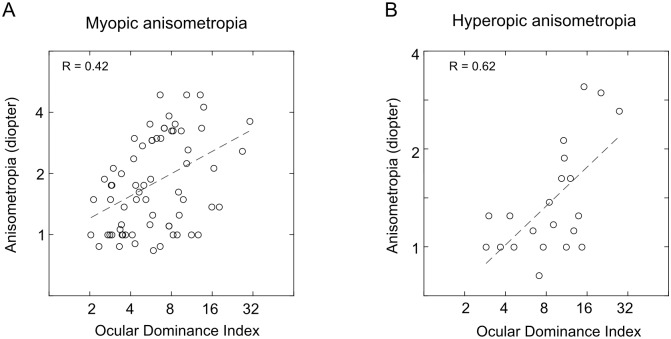
Correlation between the amplitude of anisometropia and ocular dominance index.